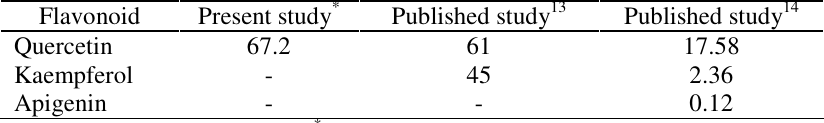
Table 5. Comparison between sunnut sample and a published study in acacia honey.